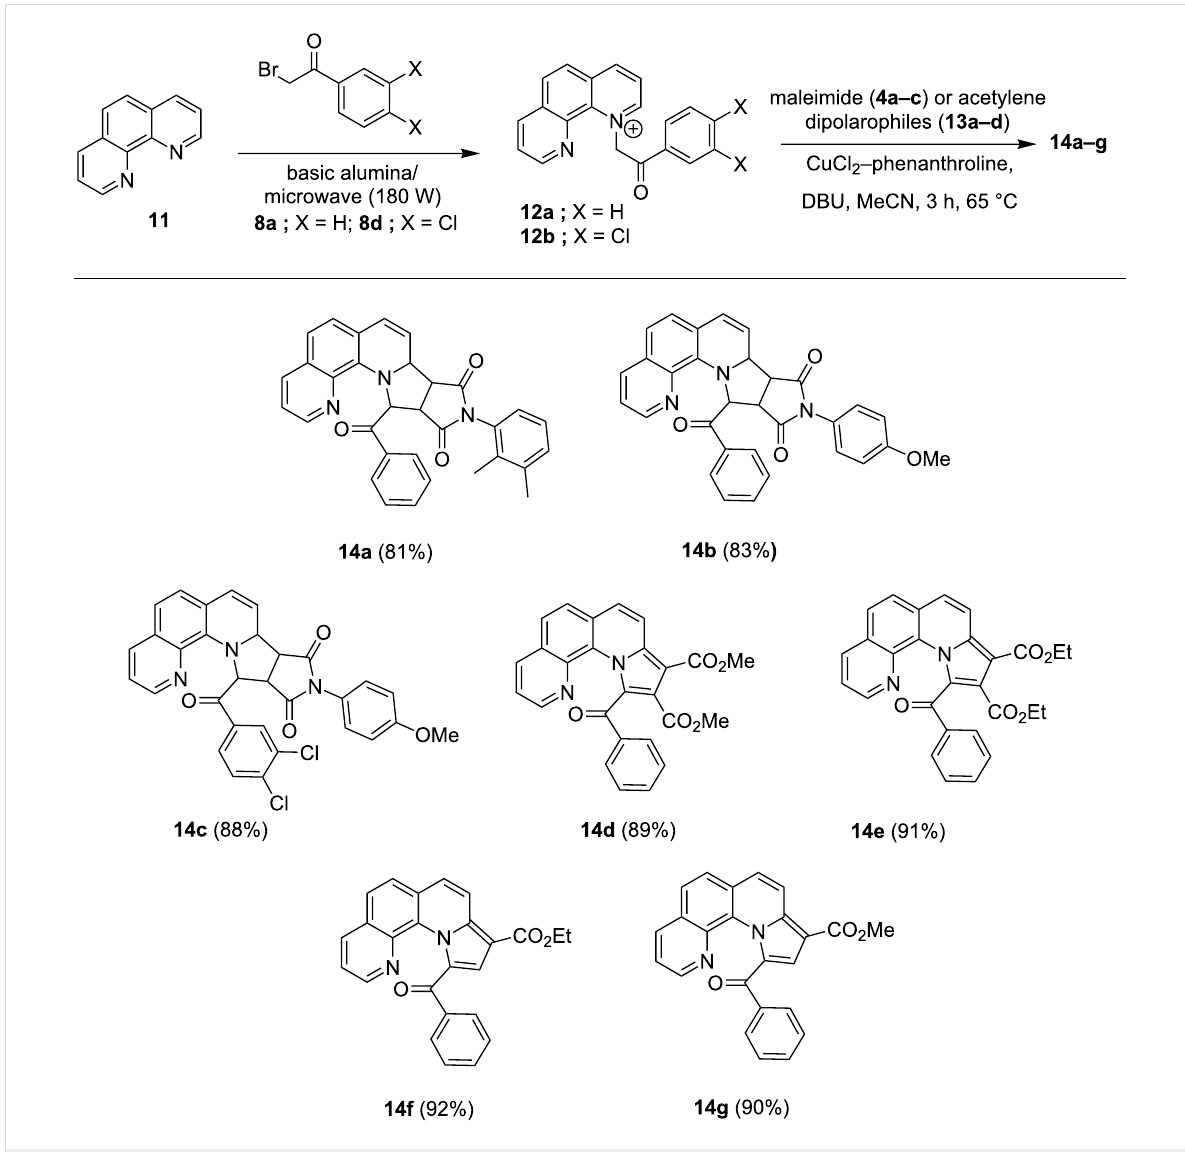
Scheme 5: Construction of pyrrolo[3 ′ ,4 ′ :3,4]pyrrolo[1,2- a ]phenanthrolines 14a – c and of pyrrolo[1,2- a ]phenanthrolines 14d – g